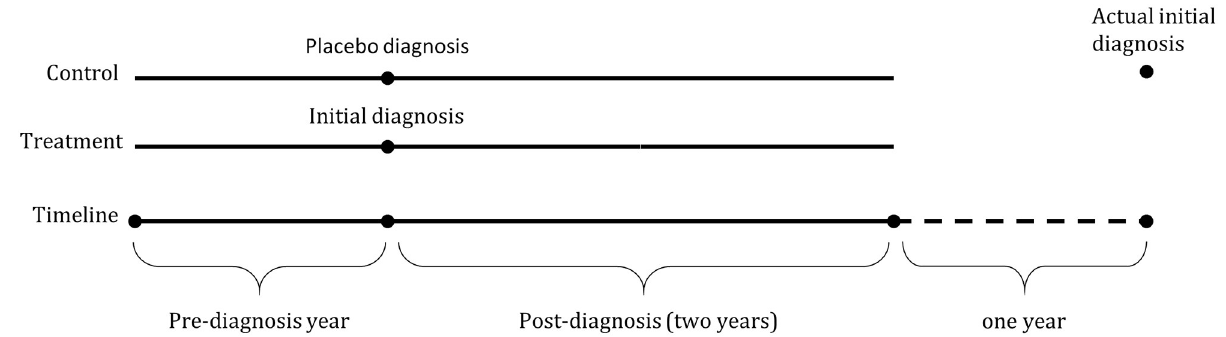
Fig 1. Illustration of the empirical setting. Solid line indicates the follow-up period used in the estimations. Data past the two-year post-diagnosis period were not analyzed in the estimations (dashed